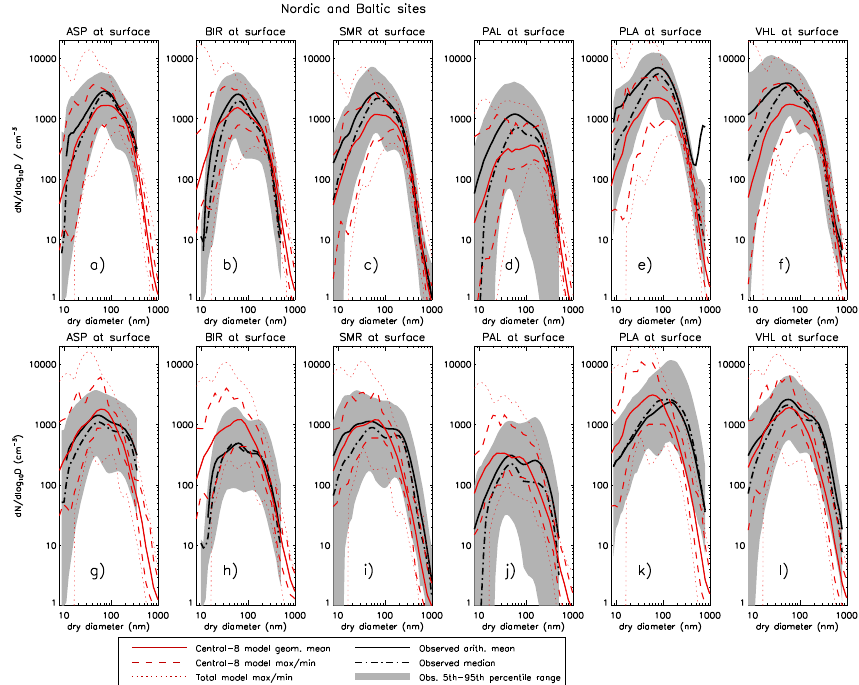
Figure 15. Summer (a–f) and winter (g–l) multi-model simulated size distributions against DMPS/SMPS measurements at the six Nordic/Baltic EUSAAR sites: Aspvreten (ASP), Birkenes (BIR), Hyytiala (SMR), Pallas (PAL), Preila (PLA) and Vavihill (VHL). Shown are the central-8 model geometric means (red solid), central-8 model maximum/minimum (red dashed) and all-12 model minimum/maximum (red dotted) of the June–July–August (arithmetic) mean size distributions at each site. Observed values (black solid line) are arithmetic means over the hourly measurement data (A. Asmi, personal communication, 2012). The published (Asmi et al., 2011) median (black dot-dashed) and 5th to 95th percentile range (grey shading) over the hourly measurement data are also shown for